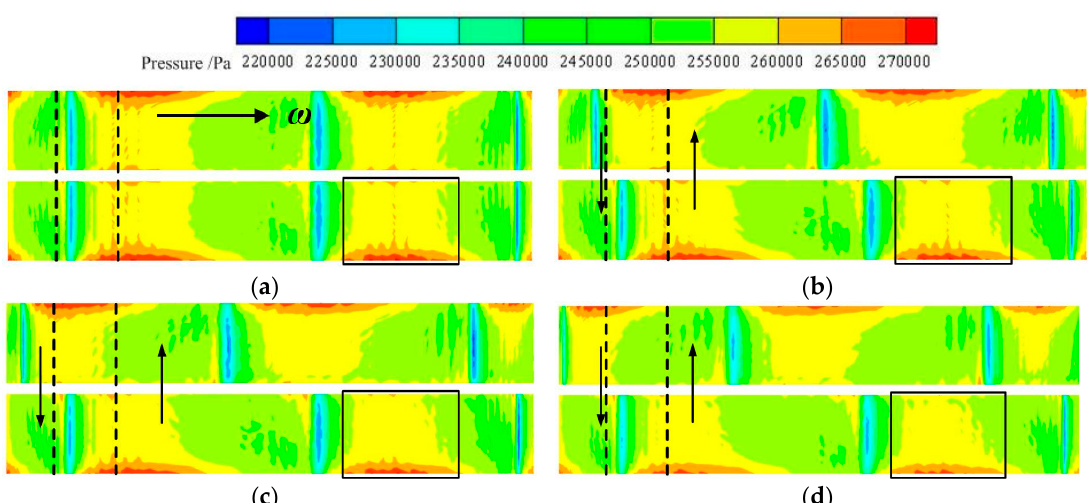
Figure 6. Pressure distribution on the outlet of impellers at rated flow rate. ( a ) Case0; ( b ) Case10; ( c ) Case20; ( d ) Case30.